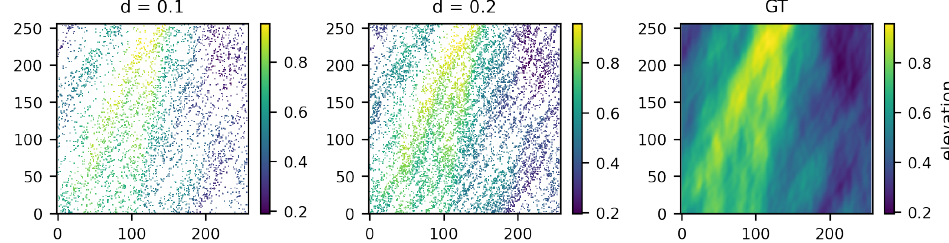
Figure 6. Example of one synthetically generated scenario with network input at different densities d = 0.1,0.2 and the corresponding ¯ O t ( right